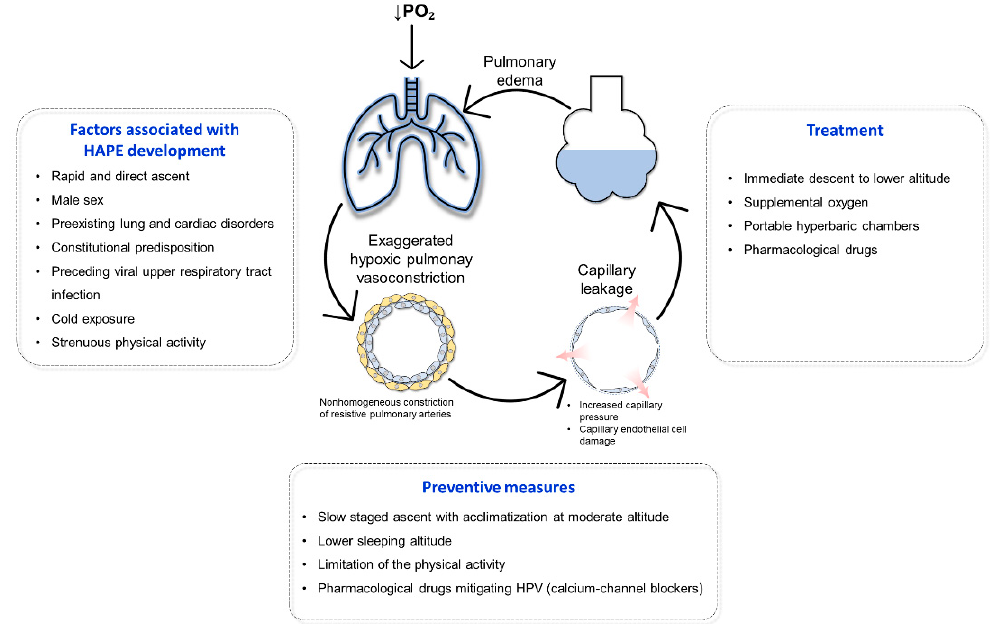
Figure 2. High altitude pulmonary edema. High altitude pulmonary edema (HAPE) develops upon acute exposure to high altitude hypoxia due to exaggerated hypoxic pulmonary vasoconstriction (HPV) and increased capillary damage and leakage due to increased capillary hydrostatic pressure. Several factors have been shown to be associated with increased incidence HAPE, including rapid and direct ascent, male sex, preexisting lung and cardiac disorders, constitutional predisposition, preceding viral upper respiratory tract infection, cold exposure, and strenuous physical activity. Few preventive measures have been shown to attenuate HPV and prevent HAPE development such as slow staged ascent with acclimatization at moderate altitude, lower sleeping altitude, limitation of physical activities, and pharmacological drugs mitigating HPV. Several management strategies have been developed to treat HAPE, such as immediate descent to lower altitude, supplemental oxygen, portable hyperbaric chambers, and pharmacological drugs.